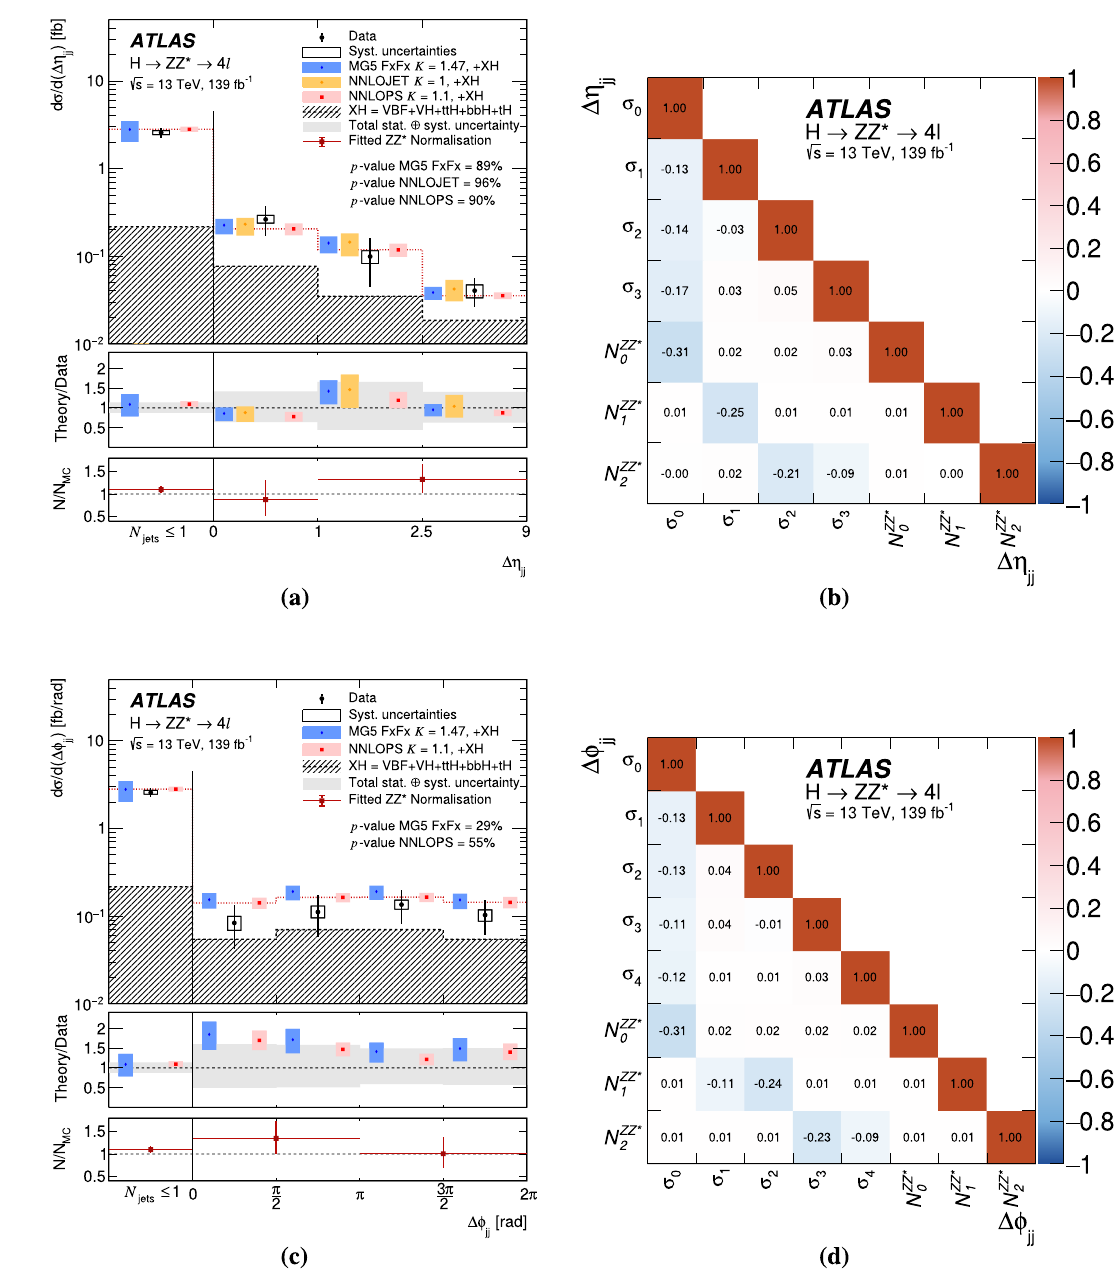
Fig. 28 Differential fiducial cross sections for a the distance between these two jets in pseudorapidity, (cid:9)η jj , and c the distance between the two jets in φ , (cid:9)φ jj . The first bin contains events with fewer than two